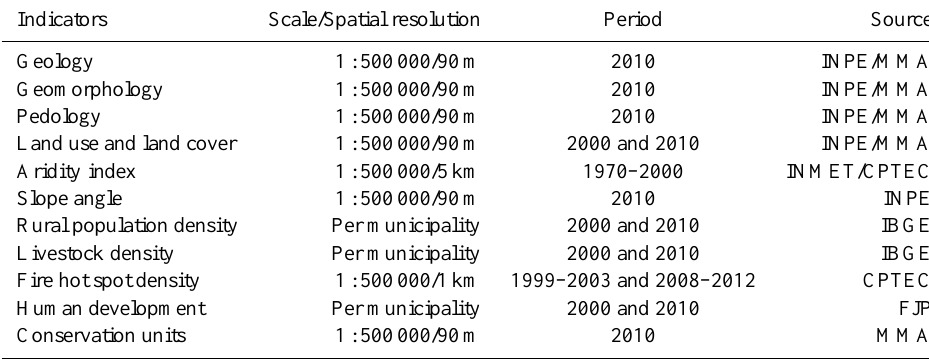
Table 1. Indicators of land degradation/desertification. Indicators Scale/Spatial resolution Period Source Geology Geomorphology Pedology Land use and land